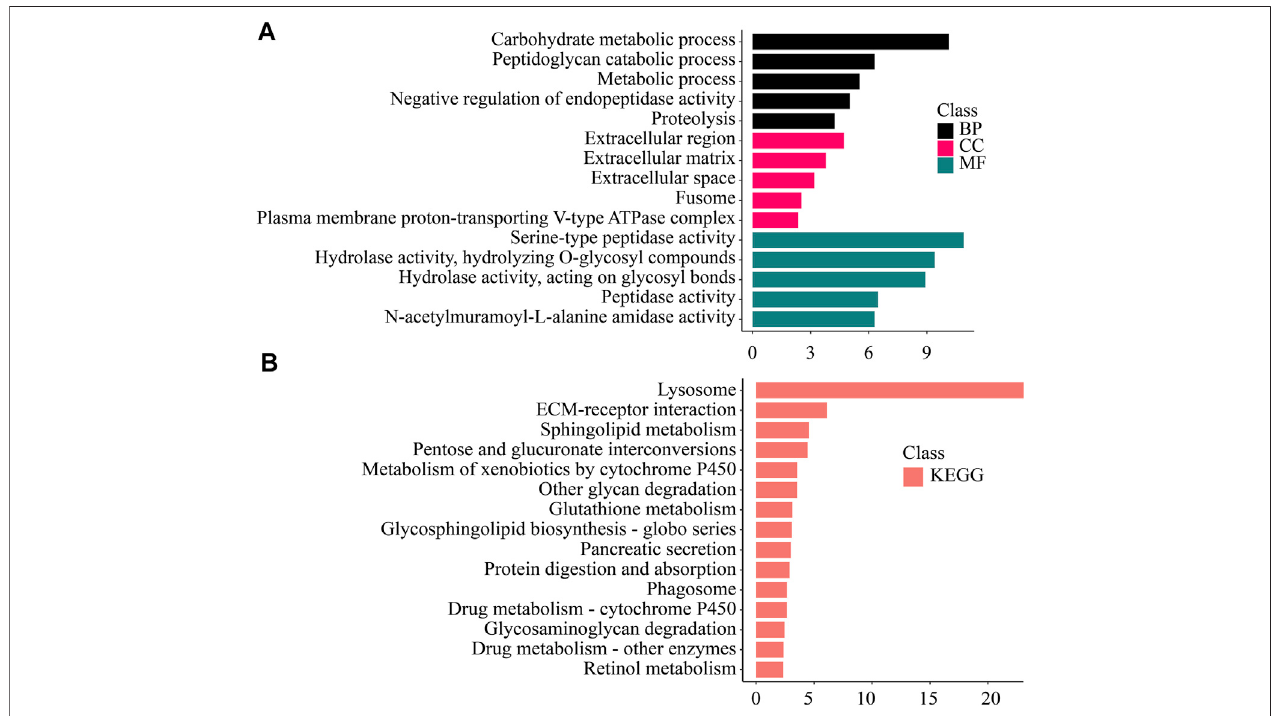
FIGURE 5 | Enrichment analysis of Hepatopancreas -speci fi c differentially expressed genes. (A) GO enrichment. BP: Biological process. CC: Cellular component. MF: Molecular function. (B) KEGG enrichment. KEGG: Kyoto Encyclopedia of Genes and Genomes; GO: Gene Ontology.